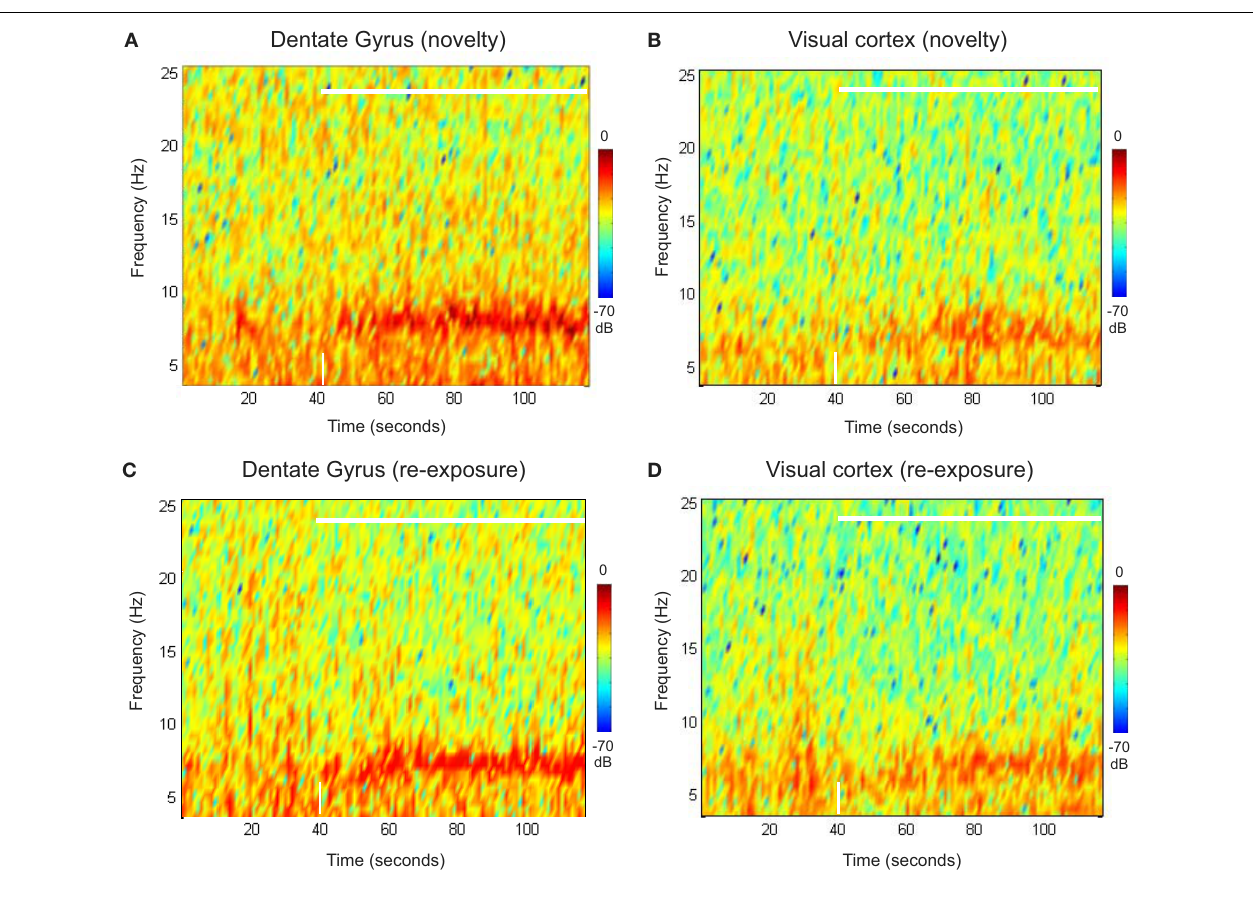
FIGURE 4 | Spectral powers of DG and VC during novel exploration and re- exposure theta periods. Representative colour-coded power spectrograms demonstrate dentate gyrus (A) and visual cortex (B) theta activity in a frequency band of 4–10 Hz during the novel objects presentation (white horizontal bar) and pre-exploration phase. Note the theta power peaks featuring in the range about